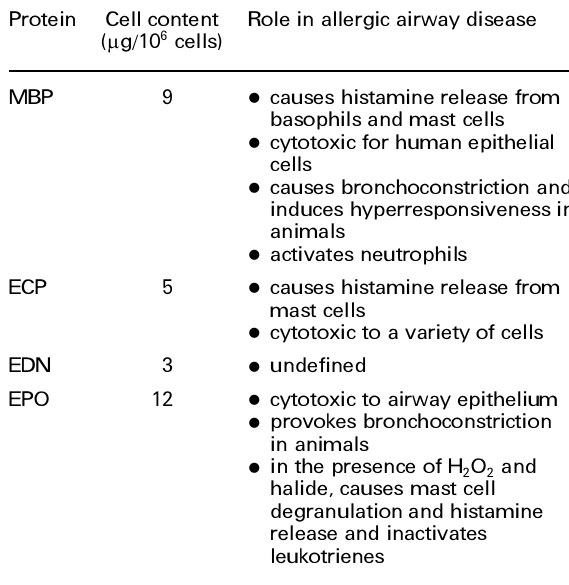
Table 2. Cationic proteins found in eosinophil granules 40